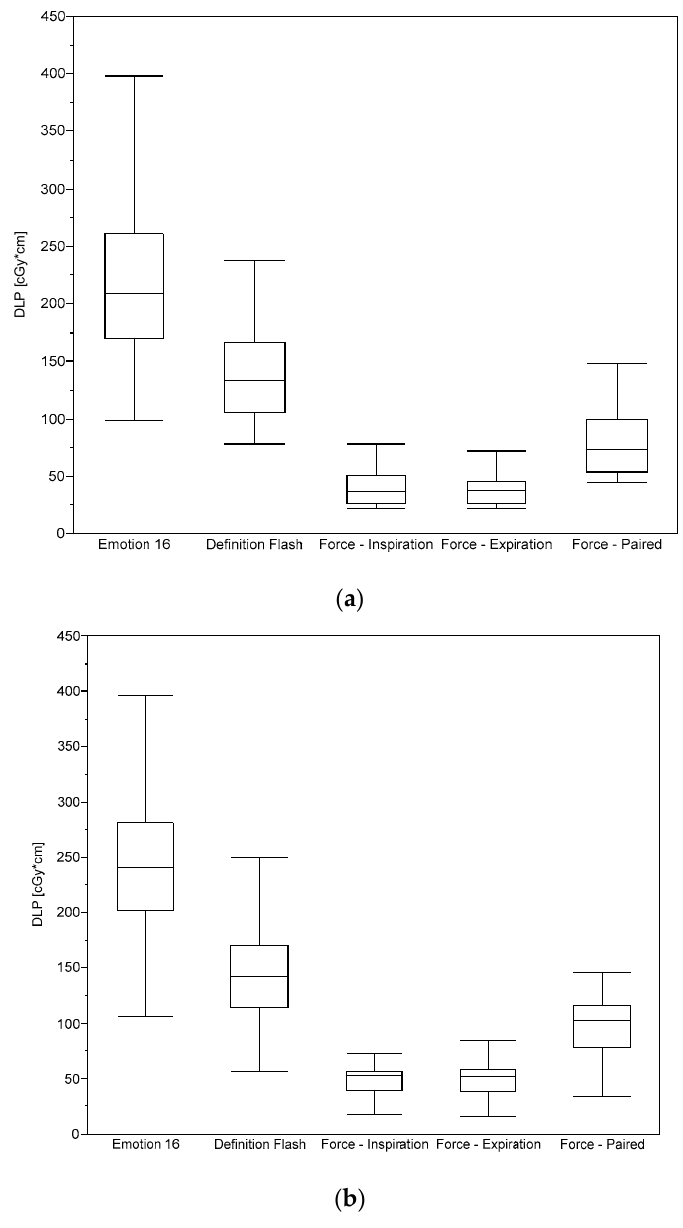
Figure 4. Dose-length-product (DLP) evaluated for ( a ) female and ( b ) male patients undergoing chest scans using the five protocols considered.